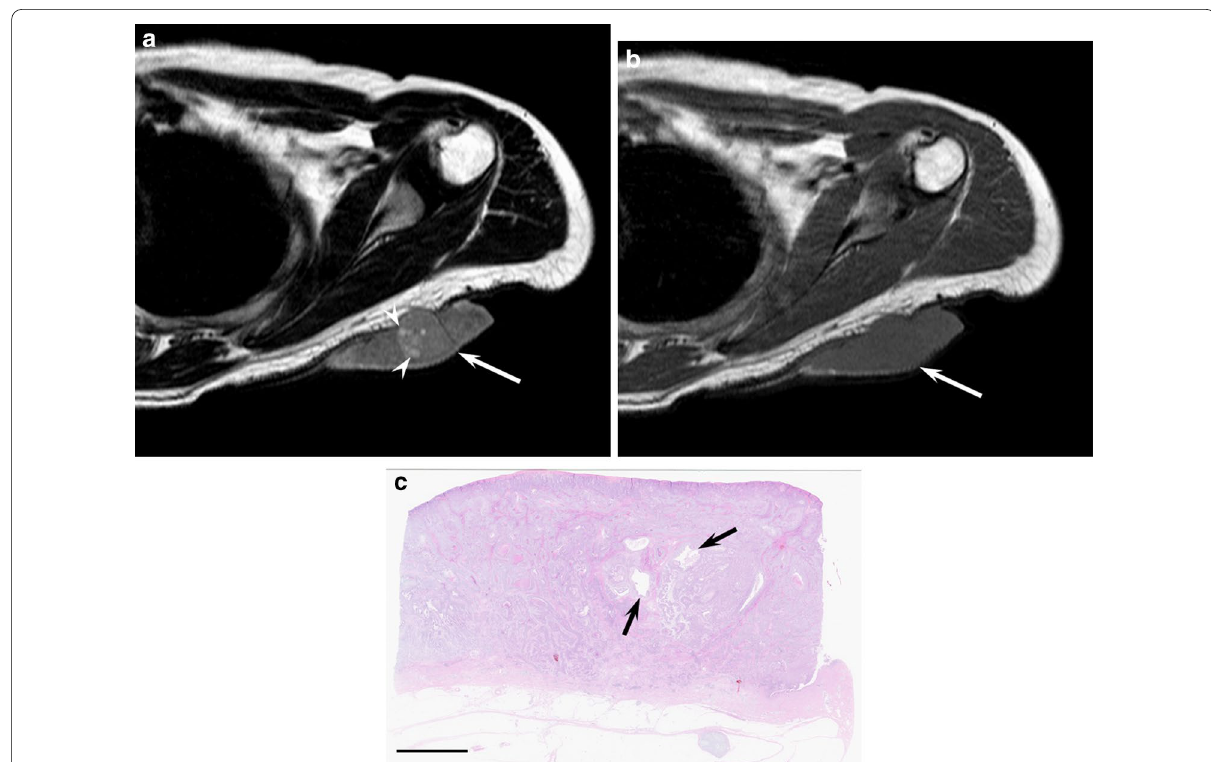
Fig. 5 A 60‑year‑old male with porocarcinoma on the upper back. a Axial T2‑weighted image showing a pedunculated mass (arrow) with T2‑hyperintese foci (arrowheads). b Axial T1‑weighted image showing slight hyperintensity compared with muscle. c Histological specimen (H&E stain; scale bar, 5 mm) showing a well‑defined mass in the dermis with multiple cystic areas